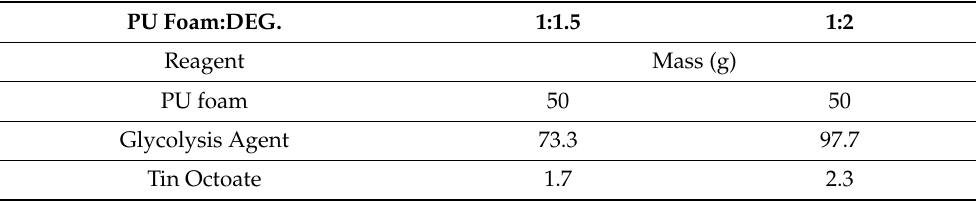
Table 1. Glycolysis reaction